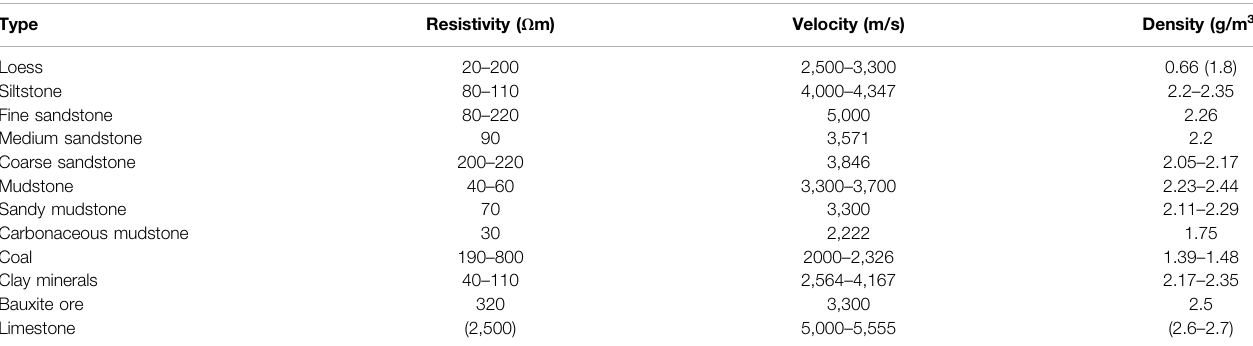
TABLE 1 | Statistical results of physical parameters of the loess, rock, and ore.